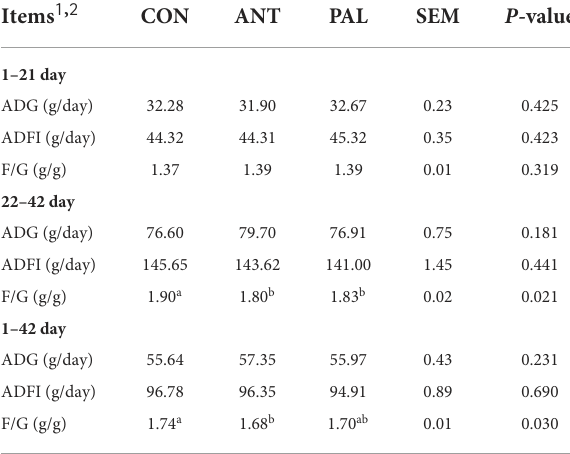
TABLE 2 Effects of dietary palygorskite supplementation on the growth performance in broilers. Items 1 ,